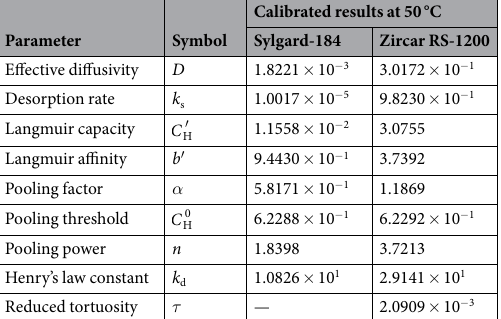
Table 1. SCE optimized parameters for triple-mode sorption in Sylgard-184 and Zircar RS-1200 at 50